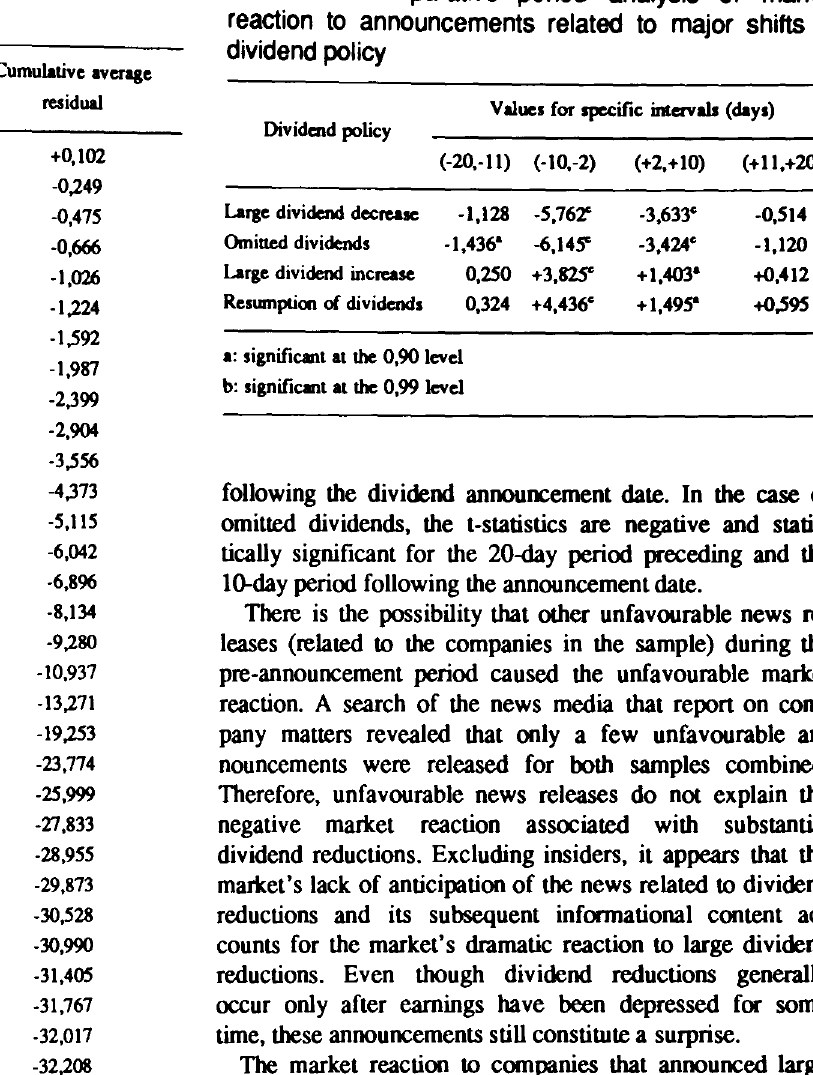
Investment return residuals for omitted divi dend sample during 1970-1988